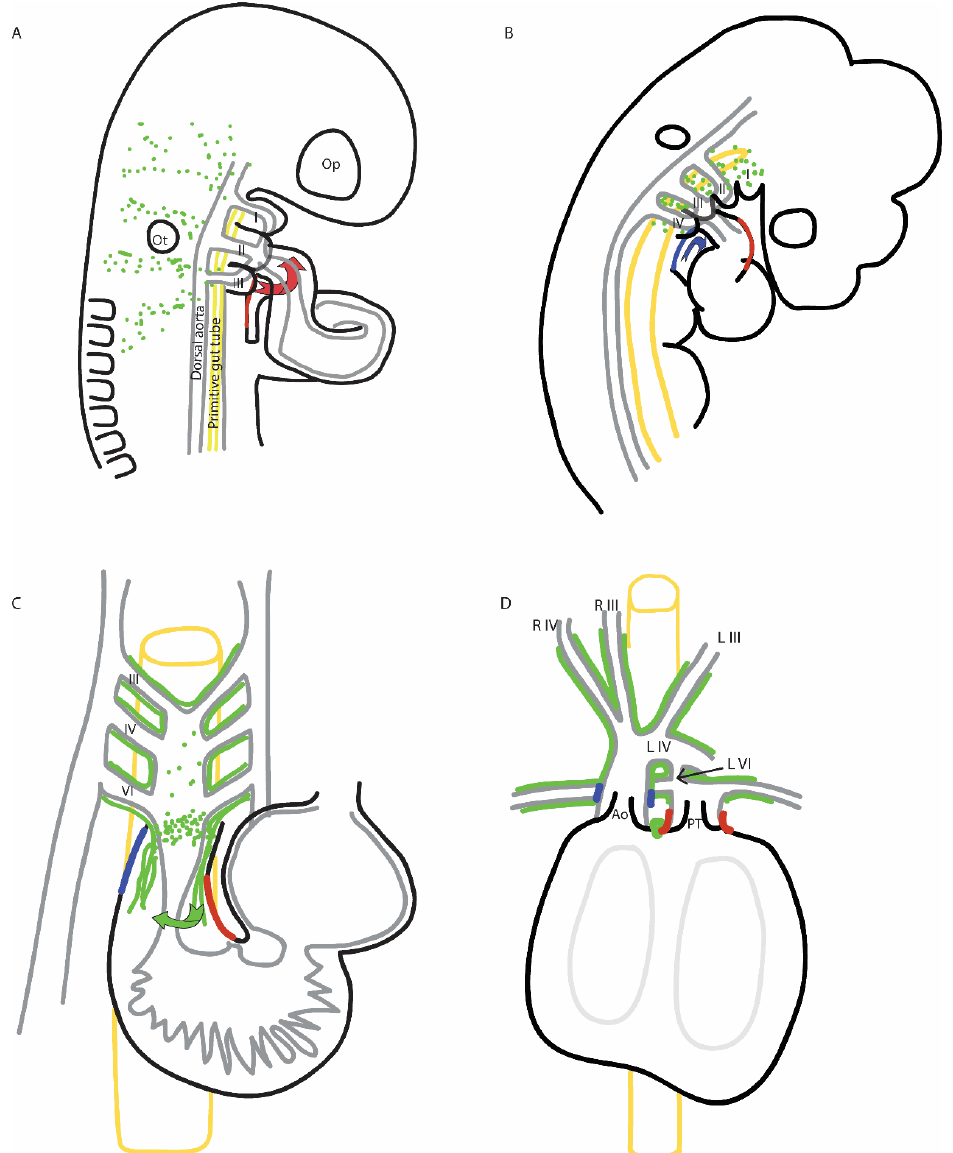
Figure 1. Schematics depict the cardiac neural crest (green) and the right side of the second heart field (red, blue) as the cells migrate toward the outflow tract, with stages based on the chick embryo. Mouse heart development is very similar, as vertebrate developmental processes are highly conserved. ( A ) At Hamburger-Hamilton (HH) stage 14, the heart is tubular, and the second heart field contributes myocardium (red) to the arterial pole; this myocardium spirals in, such that the right side of the second heart field will contribute to the left side of the outflow tract (see where the red cells migrate in panels ( B – D ). The cardiac neural crest cells (green) migrate in streams through the circumpharyngeal ridge. Blood exits the outflow tract through the second pharyngeal arch arteries. ( B ) By HH 18, the second heart field begins contributing